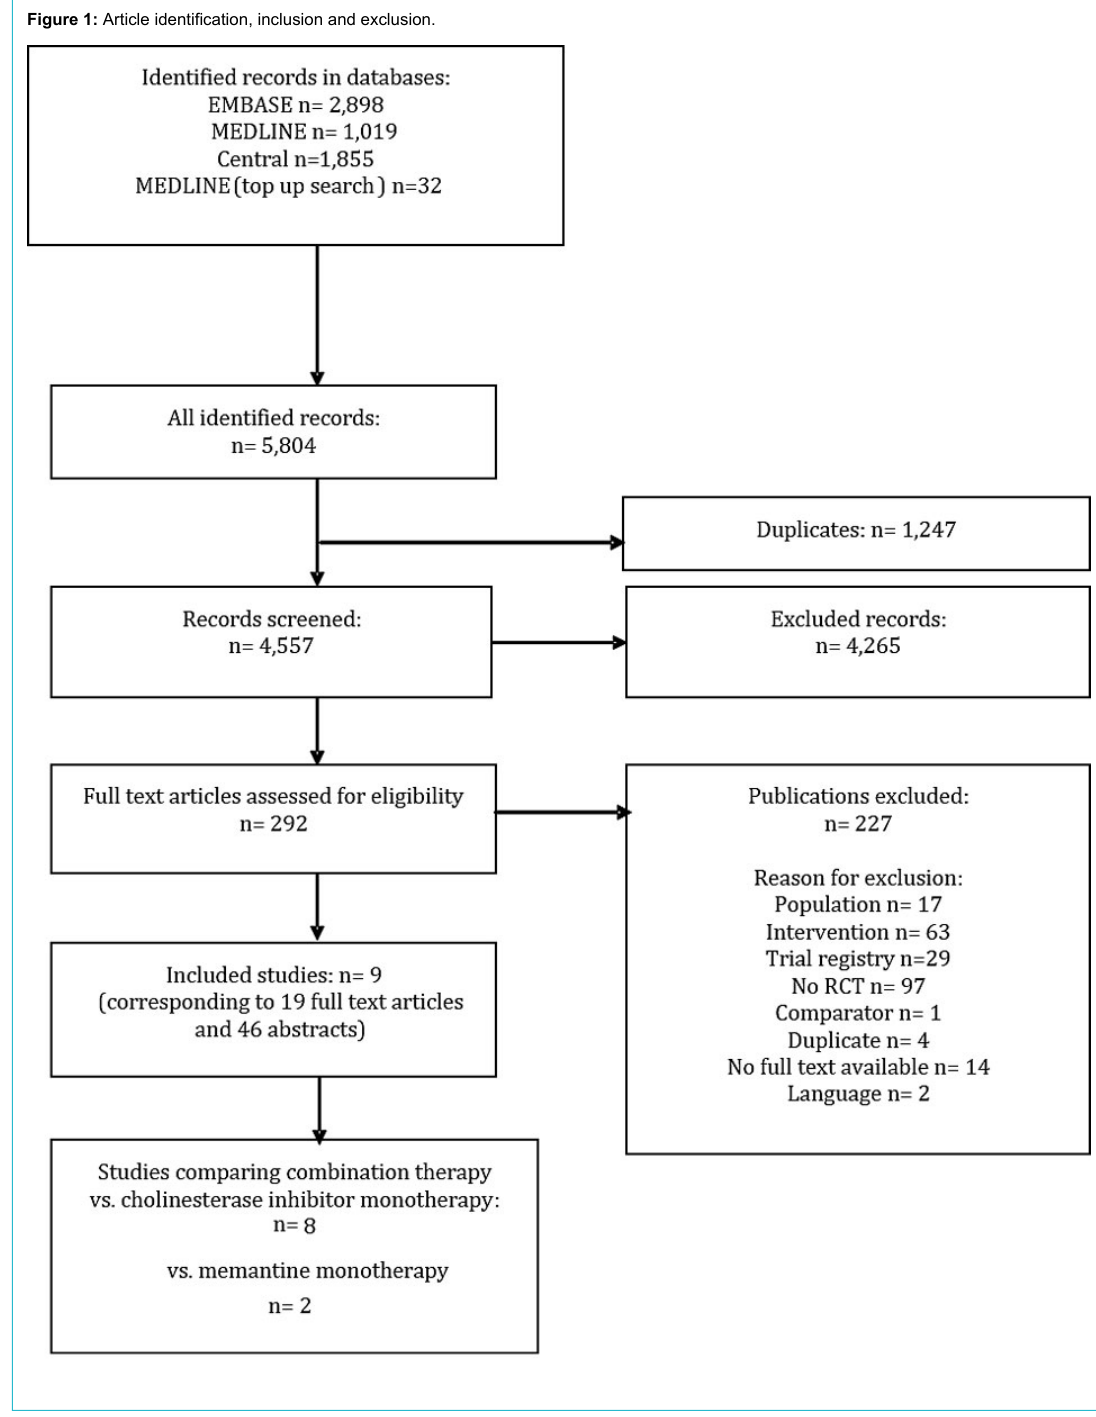
Figure 1: Article identification, inclusion and